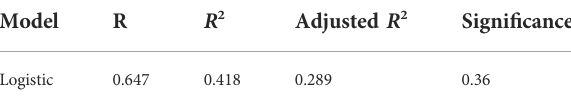
TABLE 3 Statistical table of model parameters (the single-phase gas fl ow